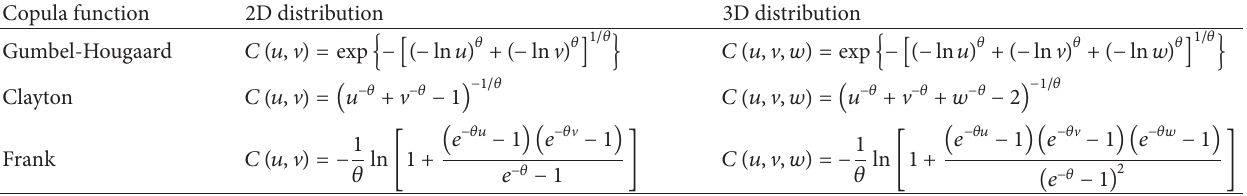
Table 1: The Gumbel-Hougaard, Clayton, and Frank Copula functions and model parameters. Copula function 2D distribution 3D